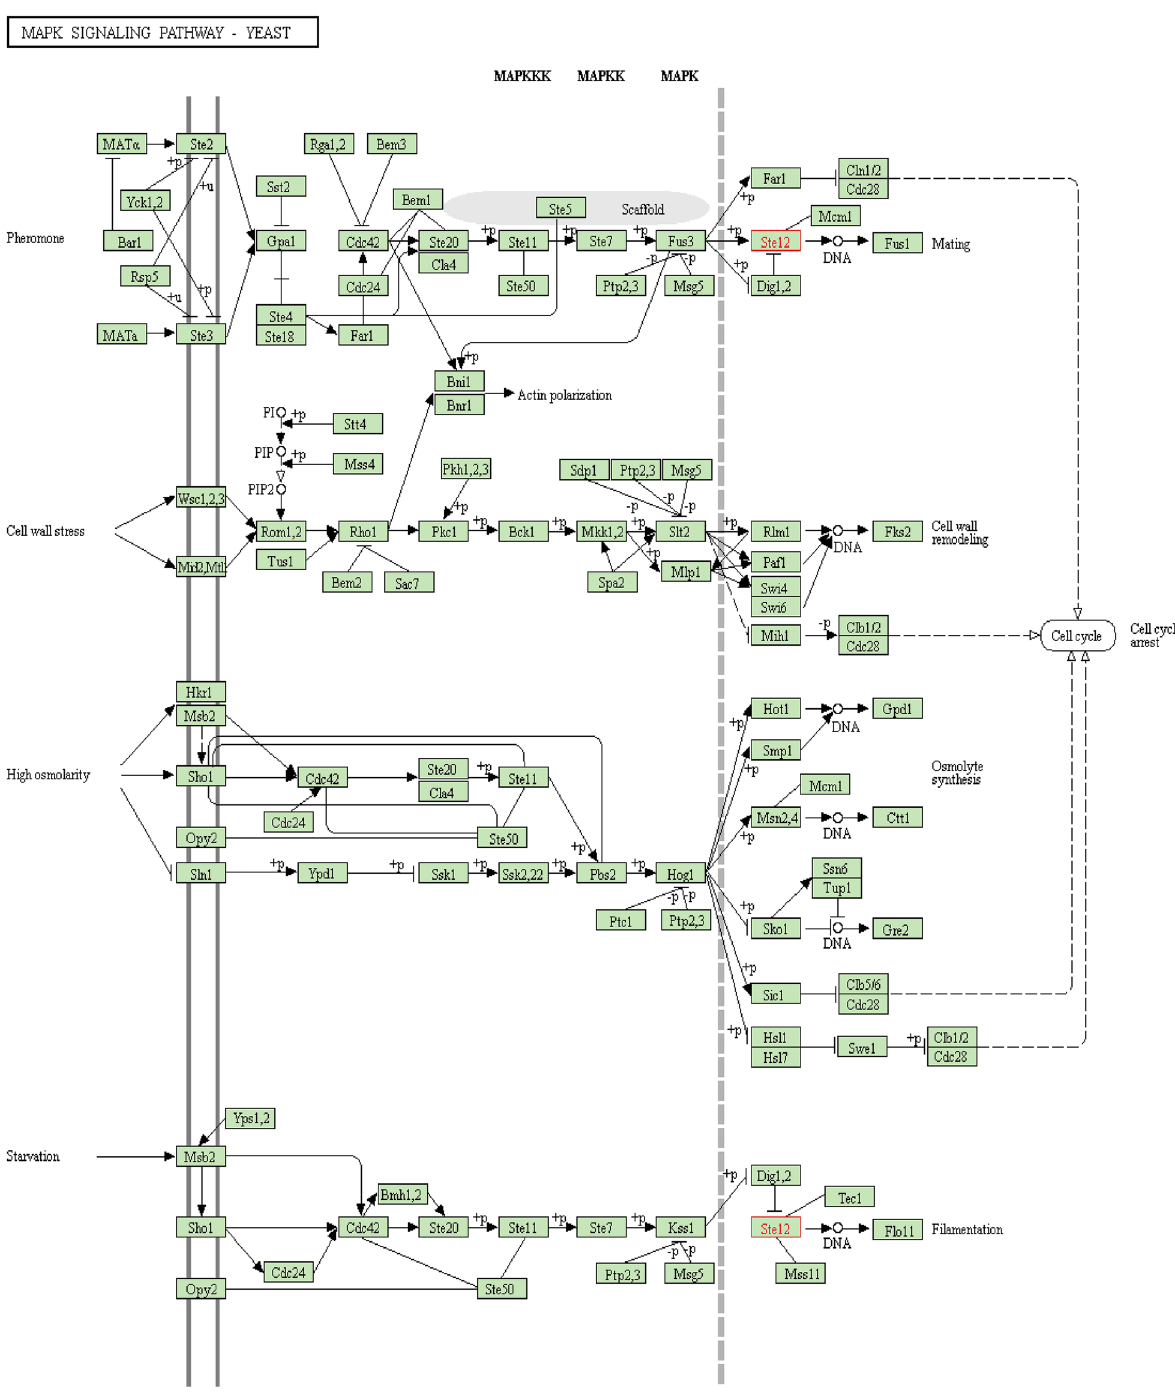
Figure 18. MAPK signaling Pathway in filamentous fungi developed by using KEGG pathway database 50 with permissions from Kanehisa Laboratories (KEGG orthology entry: K11215): The cascade of MAPK is activated through kinases and phosphatases in all eukaryotes. In fungi, it maintains the survival rate during various stress conditions through adaptations. Ste12 a fungal transcription factor involves in response to stimulation through pheromones and low nutrient conditions to endure with increased mating and filamentation ability respectively. Source: https:// www. genome. jp/ dbget- bin/ www_ bget? sce: YHR08